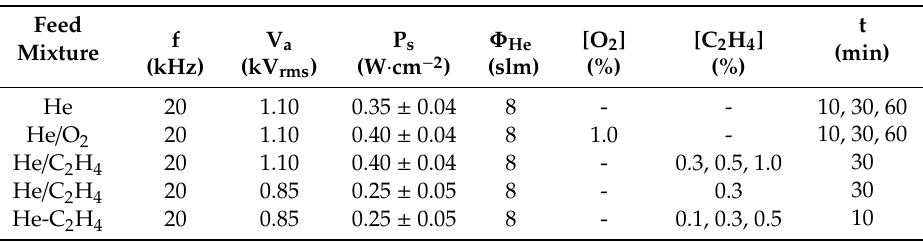
Table 1. Plasma processing conditions investigated in the present